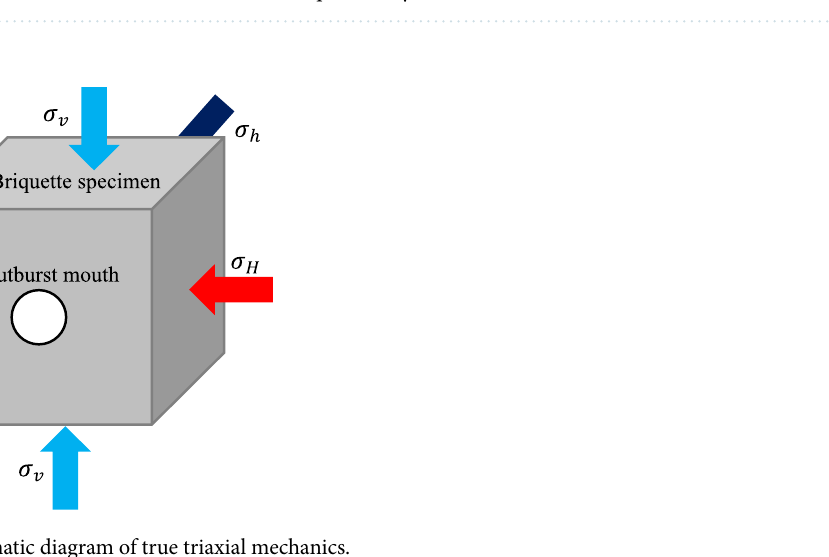
Figure 2. Schematic diagram of true triaxial